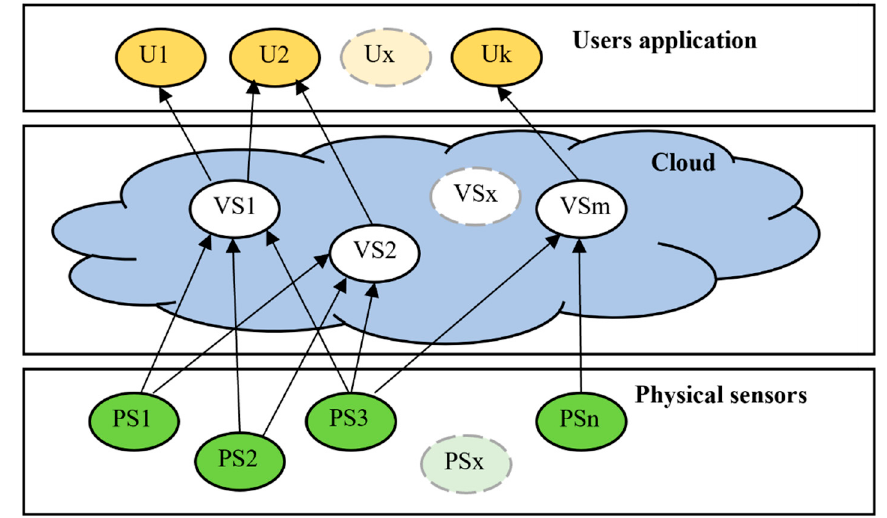
Figure 2. Virtual sensors connection.